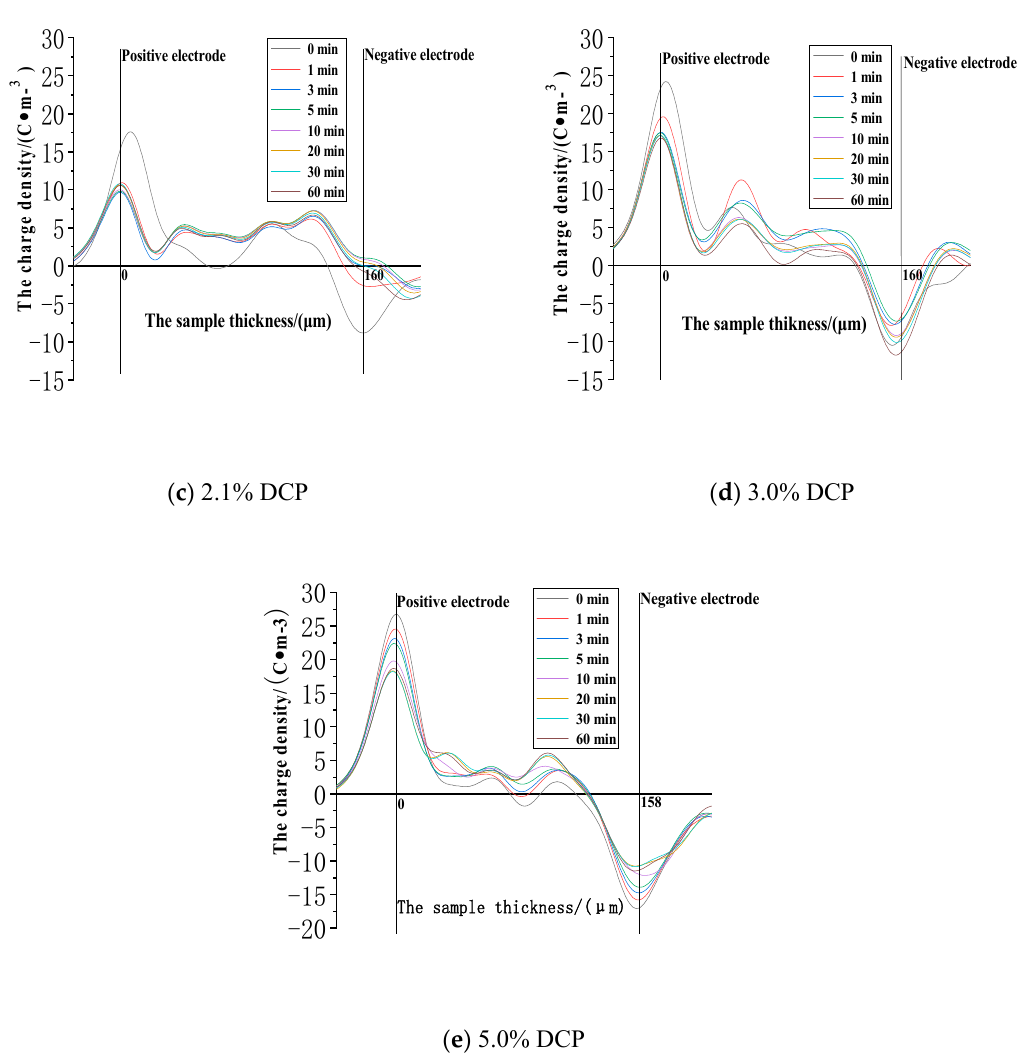
Figure 5. The space charge distribution when voltage is applied to each sample at the electric field strength of 50kV/mm. ( a ) The experimental results of the pure LDPE samples. ( b ) The experimental results of the samples with 1.0% DCP. ( c ) The experimental results of the samples with 2.1% DCP. ( d ) The experimental results of the samples with 3.0% DCP. ( e ) The experimental results of the samples with 5.0% DCP.